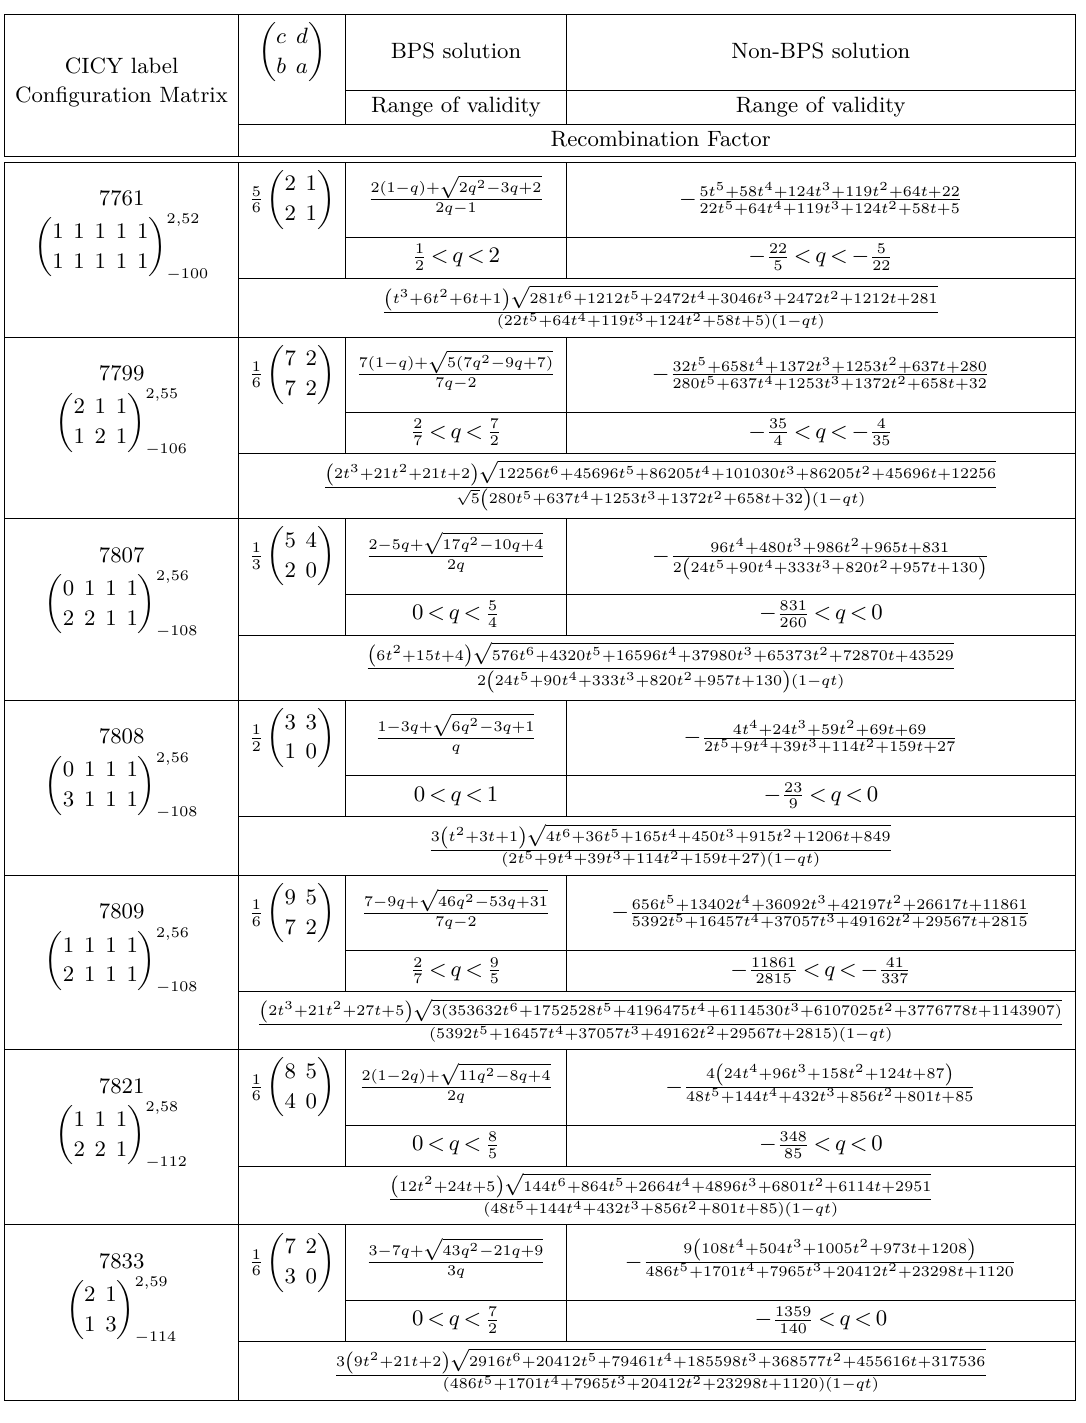
Table 2 . BPS and non-BPS extremal black holes in one-modulus CICY models,